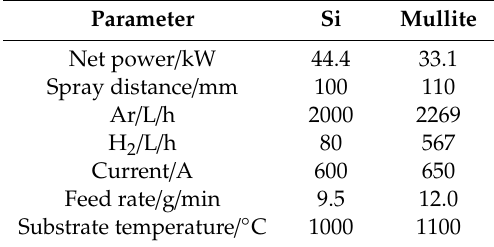
Table 2. Atmospheric plasma spraying (APS) process parameters.